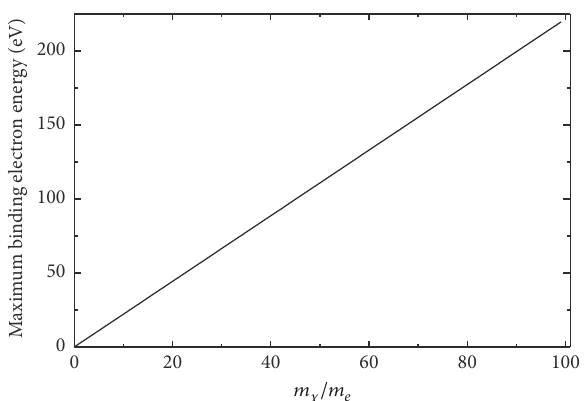
Figure 4: The maximum binding electron energy 𝑏 max in eV as a function of 𝑚 𝜒 /𝑚 𝑒 accessible to WIMP-electron scattering.